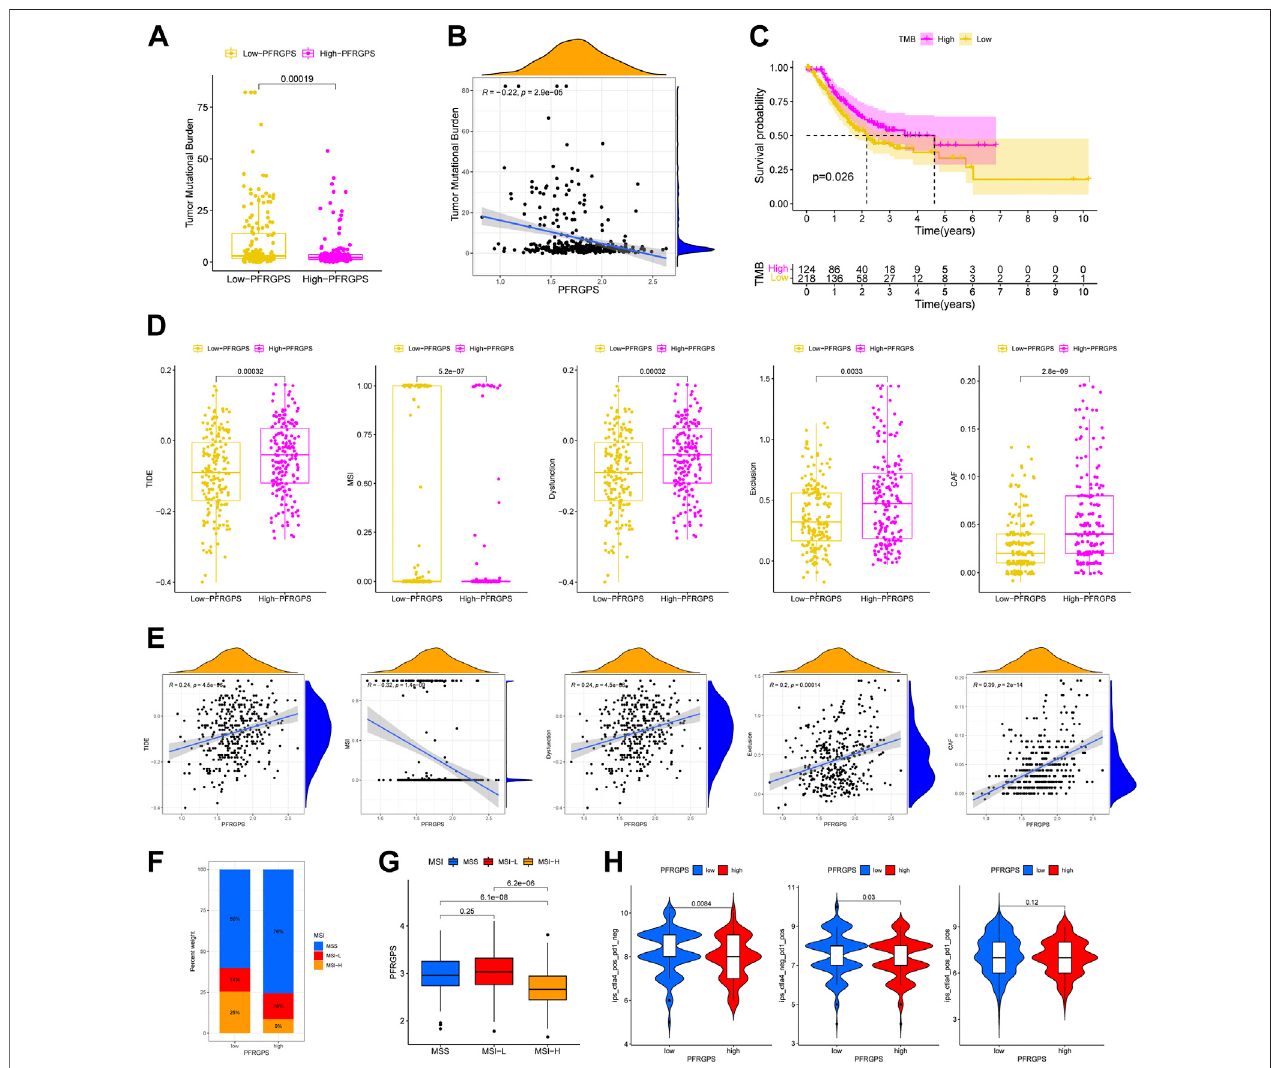
FIGURE8| Predictionofimmunotherapy response inTCGAcohort. (A) Theboxplot ofTMBdifferencesbetweenlow-PFRGPS andhigh-PFRGPSsubgroups. (B) CorrelationanalysisbetweenTMBandPFRGPS. (C) Differenceinsurvivaltimebetweenhigh-andlow-TMBgroups. (D) TheboxplotsofdifferencesbetweenTIDE,MSI, Immune Dysfunction, Immune Exclusion, and CAF scores in low- and high-PFRGPS subgroups. (E) Correlation analysis of TIDE, MSI, Immune Dysfunction, Immune Exclusion,andCAFscoreswithPFRGPS. (F) Distributionofpatients withdifferentMSIstatusesinhigh-andlow-PFRGPSsubgroups. (G) TheboxplotofPFRGPS differences between groups with different MSI. (H) The violin plots of IPS differences between low-PFRGPS and high-PFRGPS subgroups. TMB, Tumor mutation burden; PFRGPS, platelet function-related genes prognostic score; TIDE, Tumor Immune Dysfunction, and Exclusion; MSI, Microsatellite Instability; CAF, cancer- associated fi broblasts; IPS, immunophenoscore function-related genes. * p < 0.05, ** p < 0.01, *** p < 0.001, ns, not signi fi cant.